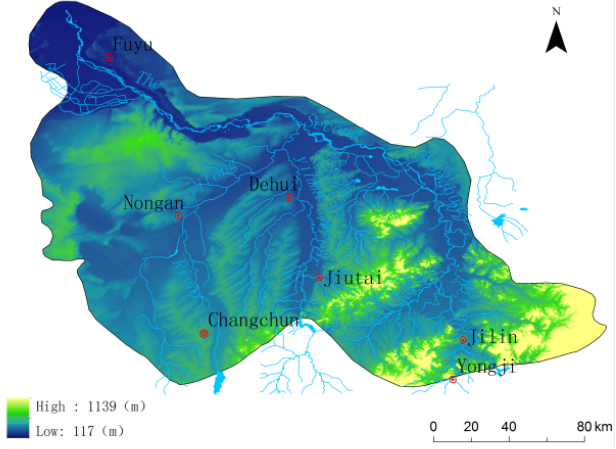
Figure 3. Surface topography of the study area.